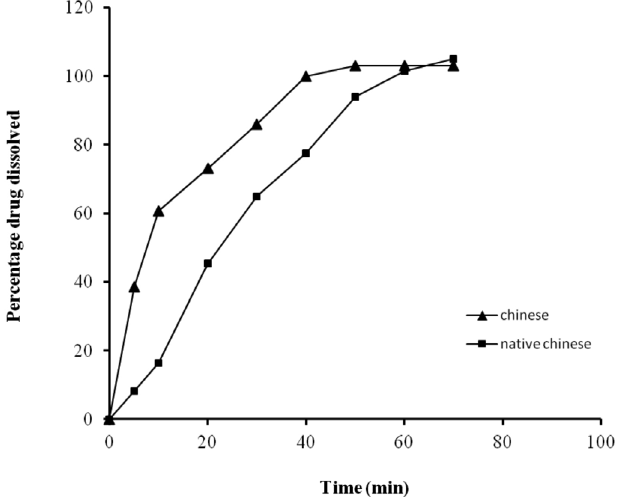
FIGURE 4 - Percentage chloroquine phosphate released over time for tablet formulations containing 10% w/w of starch binder at a packing fraction of